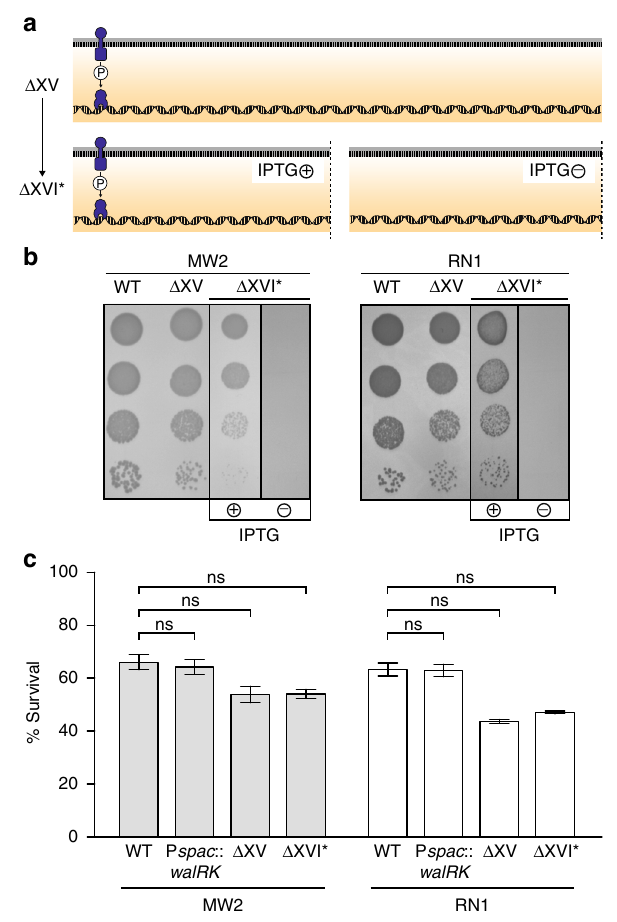
Fig. 7 Consequences of the removal of the complete TCS network in S. aureus . a Scheme of the TCSs present in Δ XV and Δ XVI* strains. Δ XVI* strain harbors the walRK operon under the P spac IPTG-inducible promoter. IPTG presence in the media controls the expression of walRK in this strain. b Growth of S. aureus strains de fi cient in the TCS network at 37 °C in rich media. Drops of serial dilutions from bacterial cultures were spotted on TSA plates. IPTG was added to the media when indicated. c Survival of S. aureus Δ XVI* during starvation-induced growth arrest. The percentage of viable cells remaining after 7 days of growth arrest was